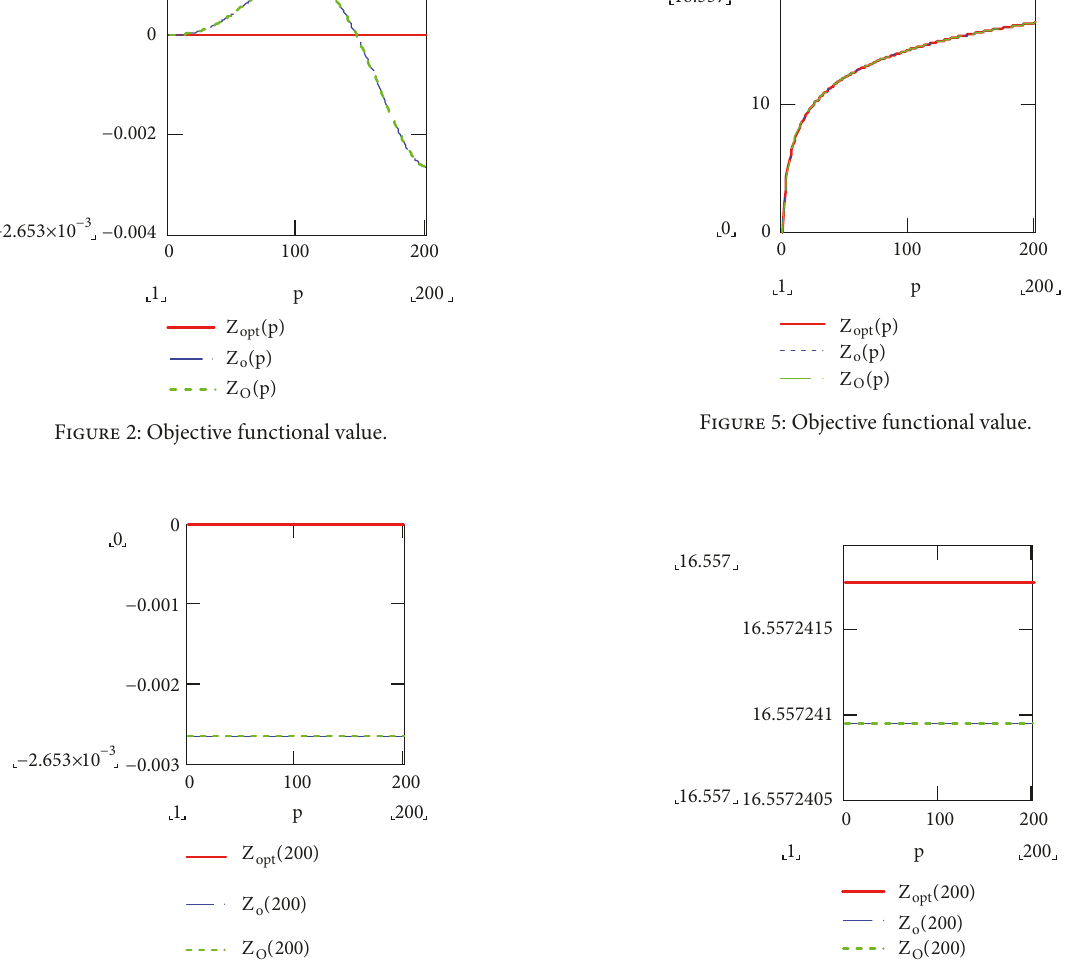
Figure 6: Objective functional value at the final